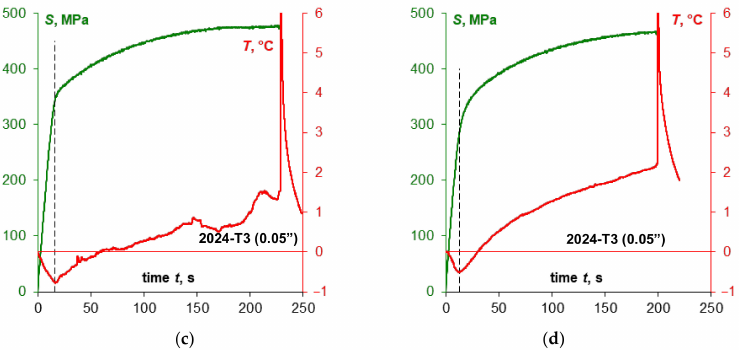
Figure 10. The summary of stress S and temperature T change curves obtained during monotonic tensile tests of specimens made of 0.16” thick 2024-T3 sheet plate ( a , b ) and 0.05” thick 2024-T3 sheet plate ( c , d ) depending on the specimen cutting direction in relation to the sheet plate rolling direction.